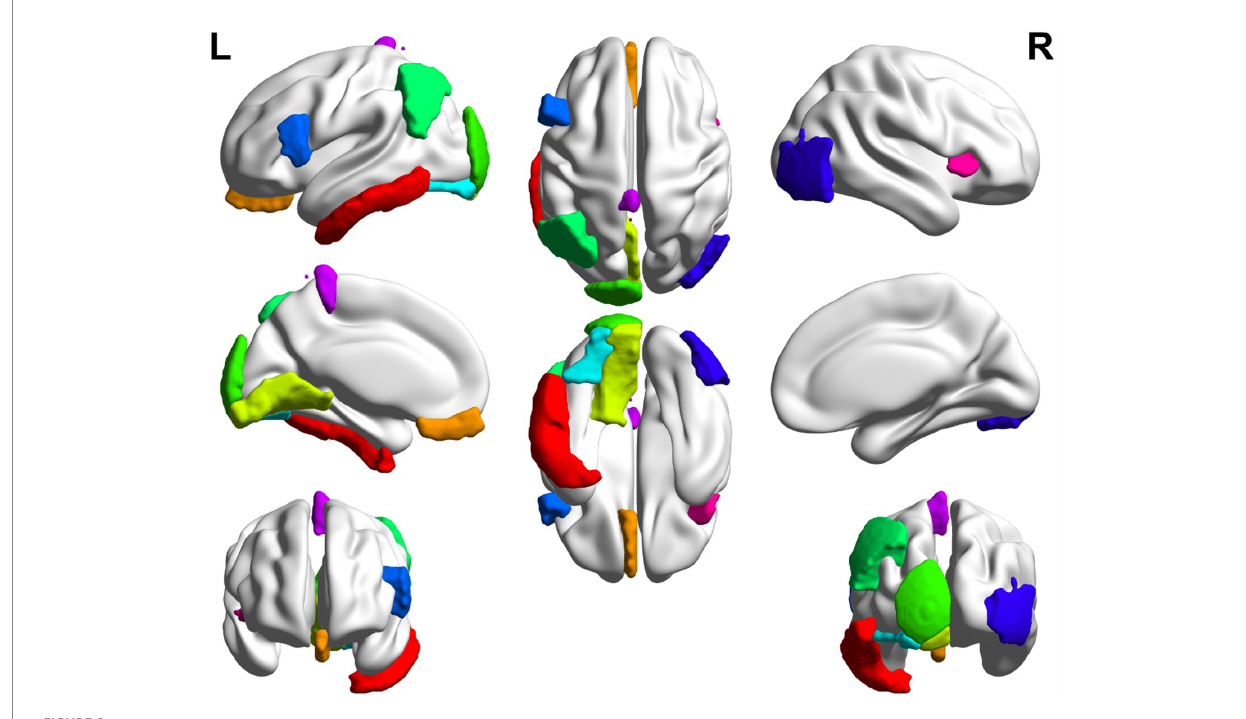
FIGURE 6 Top 10 ROI visualization of AD group.